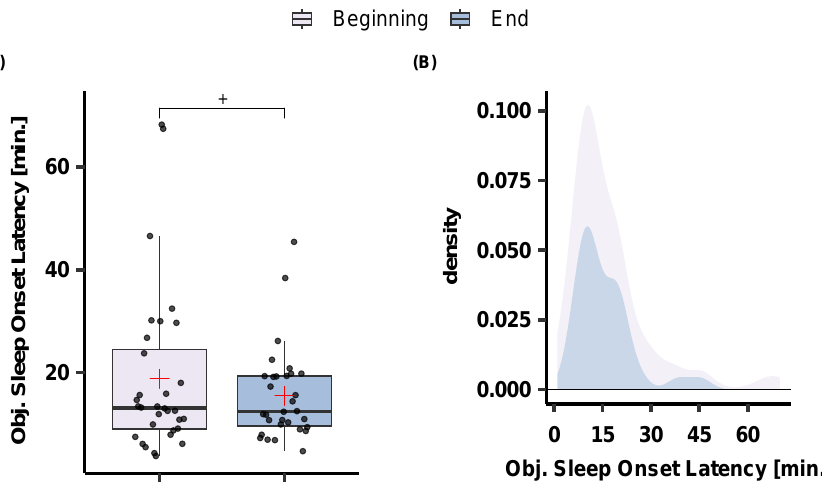
Figure 7. The effects of sleep training on ( A ) objective sleep onset latency as extracted after MCNN sleep classification and ( B ) the respective density plot. Note a trend for a decrease in sleep onset latency at the end of the sleep training program. p < 0.1 +.